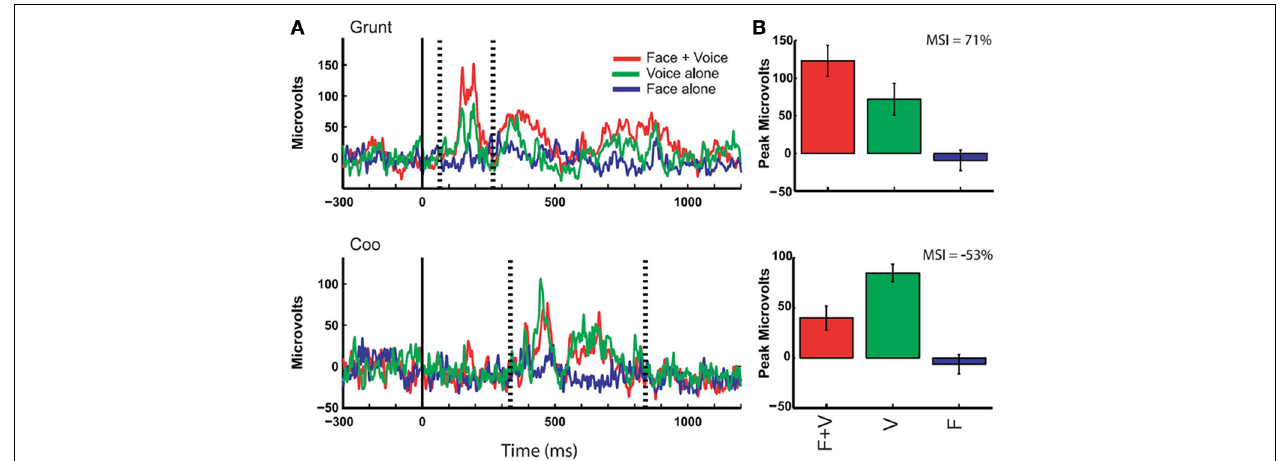
FIGURE 5 | Responses of auditory cortex (core region) to multimodal vocalizations. Rectified local field potentials compare responses to face + voice(F + V),voicealone(V),andfacealone(F)componentsofcoosandgrunts (non-human primate vocalizations commonly emitted during affiliative social interactions) in order to examine multisensory integration of social signals through communication. LFPs were recorded in auditory cortex of awake behaving rhesus monkeys while they viewed vocalizing conspecifics, and integration of faces and voices was observed through changes in LFP activity.